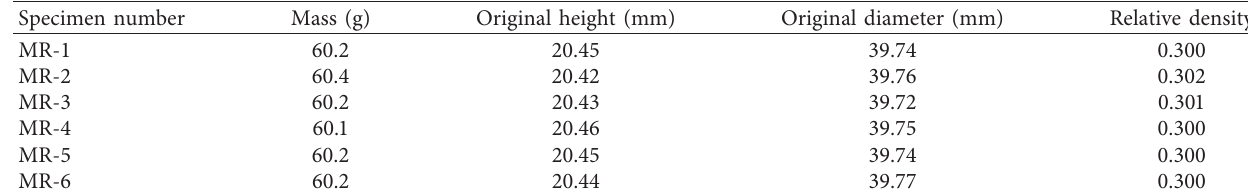
Figure 1: (a) Non molding direction of MR; (b) Molding direction of MR; (c) Magnified view of MR. Table 1: Original process parameters of MR specimens